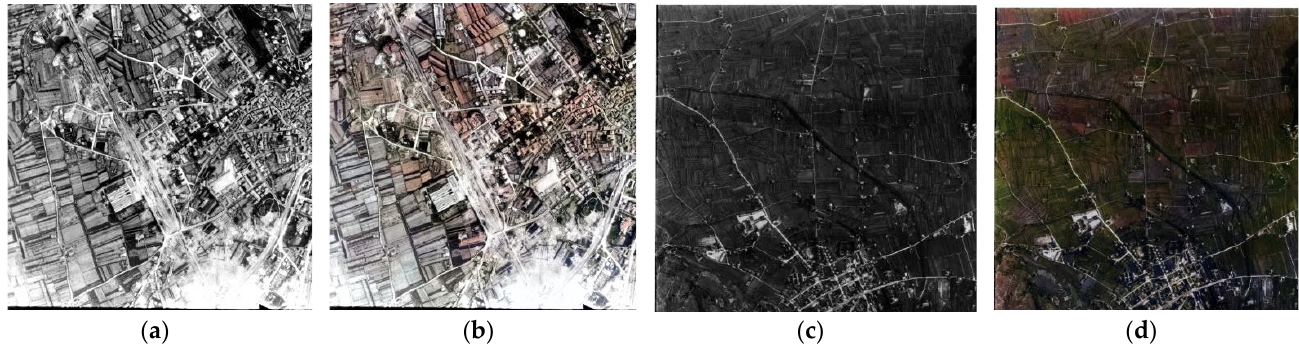
Figure 9. Colorization outputs ( b ) and ( d ) Hyper-U-NET with historical photos affected by unbalanced contrast/brightness levels ( a ) and ( c ), and depicting an urban area ( a ) and the surrounding countryside and a mostly rural ( c ) environment.